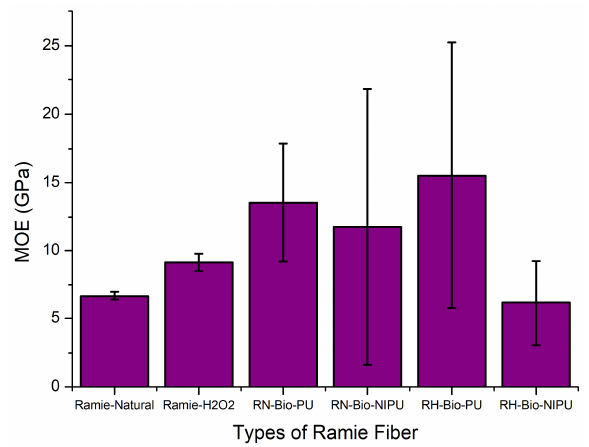
Figure 15. Modulus of elasticity (MOE) of different types impregnated ramie